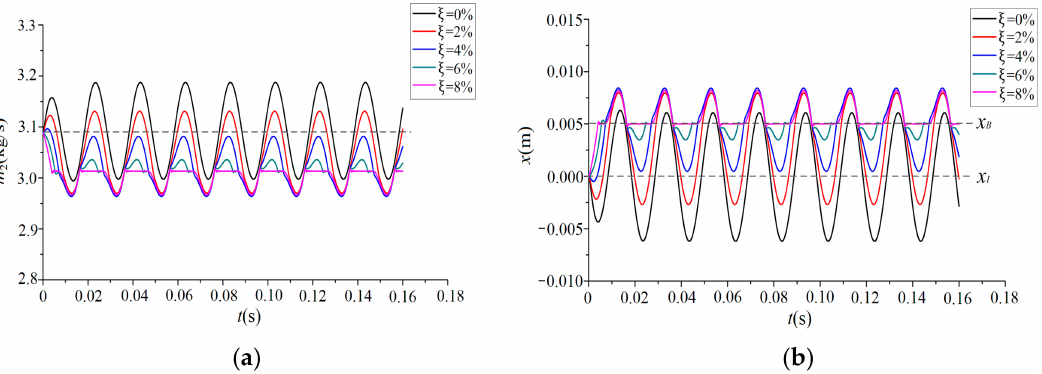
Figure 8. Parameters variation with the time under different ξ . ( a ) Export flow. ( b ) Shock